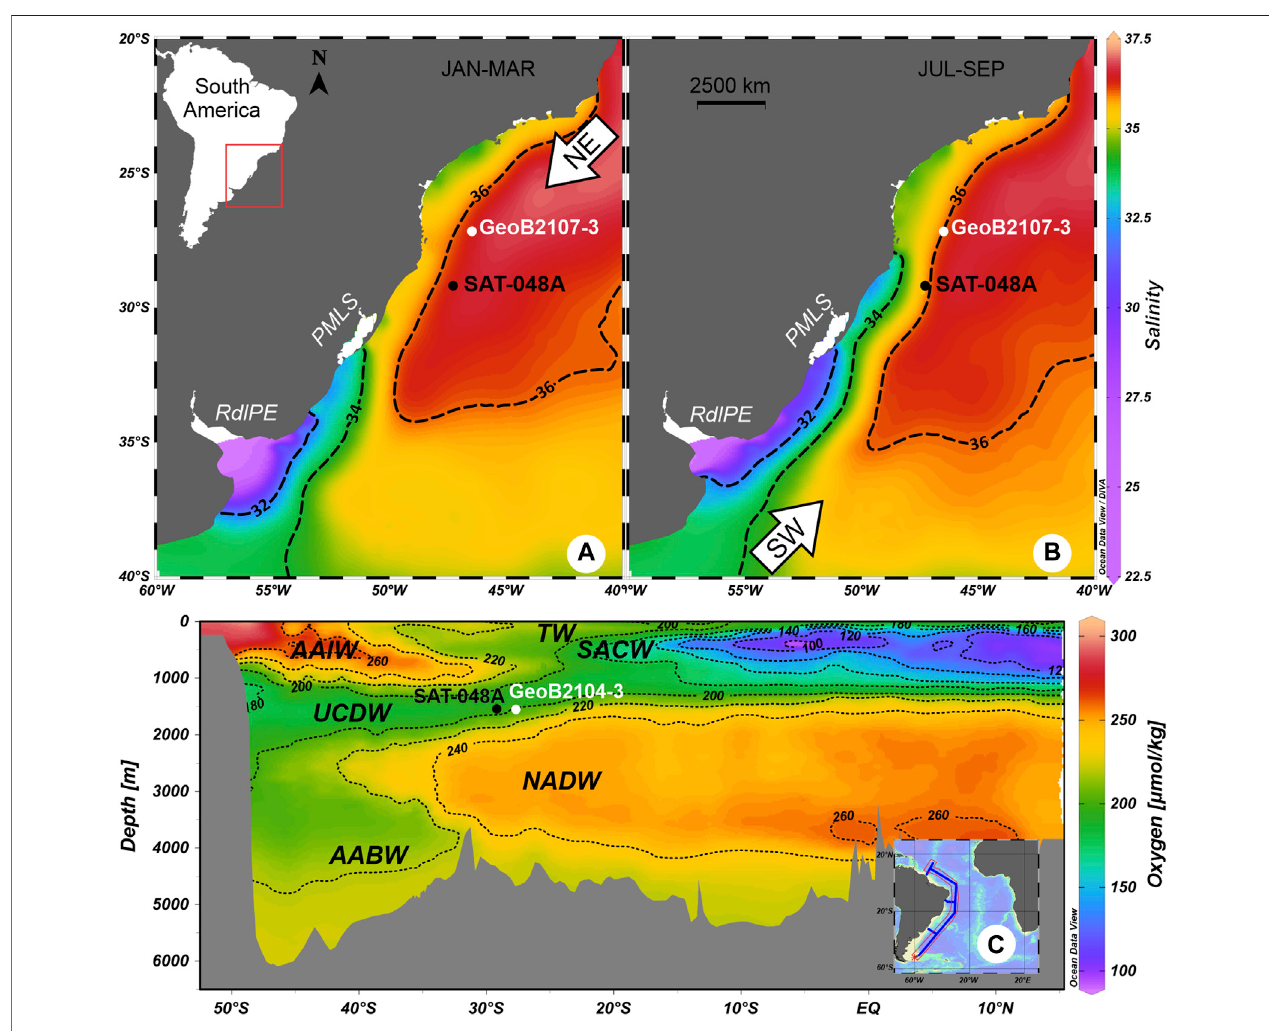
FIGURE 1 | Location of sediment core SAT-048A and other mentioned cores (GeoB2107-3, Gu et al., 2017, Pereira et al., 2018; GeoB2104-3, Howe J. N. W. et al., 2016) in the studied area, in map view (A,B) and as latitudinal cross section (C). Seasonal variation of average sea surface salinity (measured on the psu scale) for the months of (a) January – March (austral summer) and (b) July – September (winter) are based on data from the World Ocean Atlas 2013 (WOA13, Zweng et al., 2013). The isohalines 32, 34, and 36 (dashed lines) highlight the northward intrusion of less saline water from the south during winter (b) when compared to summer (a) conditions. This is related to seasonally predominating wind regimes, indicated as white arrows. The present Río de la Plata Estuary (RdlPE) and Patos-Mirim Lagoon System(PMLS) represent importantcontinentalnutrientsourcesin thestudyarea. Dissolved oxygen concentrations(c;µmol/kg)inatransect along the SouthAmerican continental margin show the South Atlantic water masses that circulate in the region: Tropical Water (TW), South Atlantic Central Water (SACW), Antarctic Intermediate Water (AAIW), Upper Circumpolar Deep Water (UCDW), North Atlantic Deep Water (NADW), and Antarctic Bottom Water (AABW).